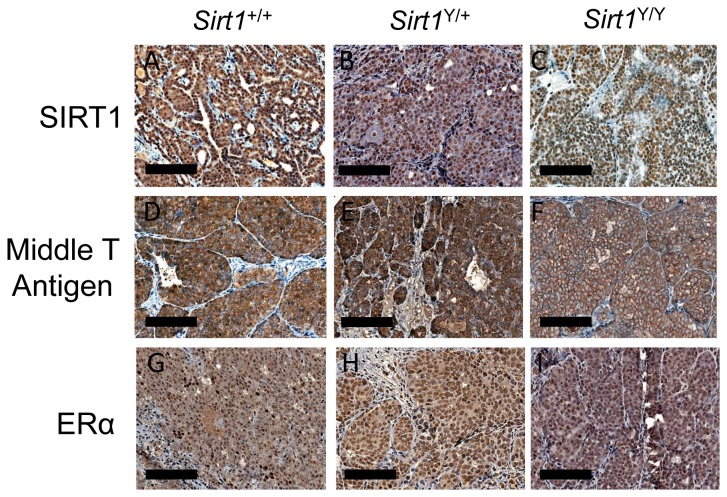
Expression of SIRT1, Middle T Antigen, and ERα protein in mammary tumors.Representative immunohistochemical staining for SIRT1 (A-C), Middle T Antigen (D-F), and ERα (G-I) in mammary tumors collected at humane endpoint from Sirt1
+/+, Sirt1
Y/+ and Sirt1
Y/Y mice at 200X magnification (scale bars, 100 μm).